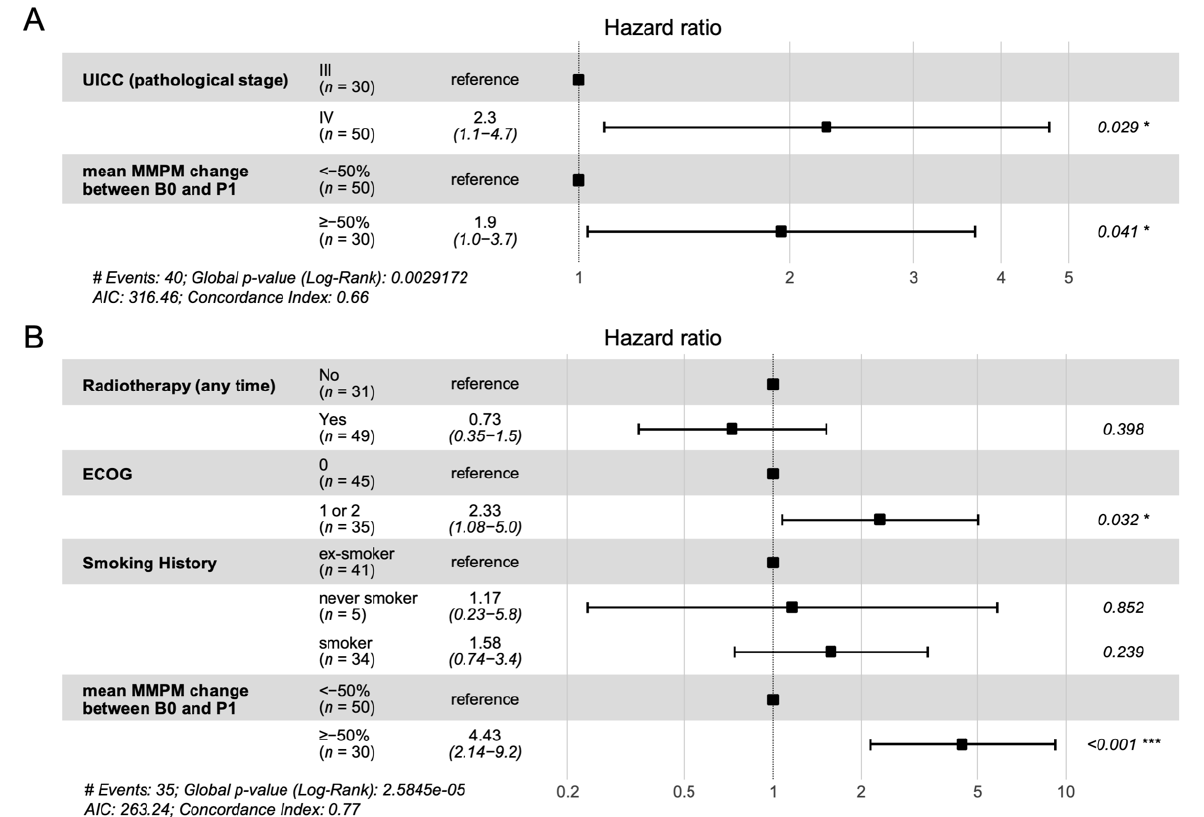
Figure 4. Multivariate Cox regression analysis of survival. Forest plots displaying hazard ratios from multivariate analysis of progression-free survival ( A ) and overall survival ( B ) for >50% vs. ≤50% decrease in mean mutant molecules per milliliter (MMPM) ctDNA. * p ≤ 0.05 *** p ≤ 0.001. In the 51 subjects with both a baseline plasma and post-chemotherapy cycle 2 plasma, those with ≤ 50% decrease in ctDNA level in the P2 plasma had a lower 6-month progression- free survival rate (29% vs. 73%, HR 4.3, 95% CI 1.8 to 10, log-rank p < 0.001) and a lower 12-month overall survival rate (37% vs. 75%, HR 3.2, 95% CI 1.3 to 8.2, log-rank p = 0.009) (Figure 5).